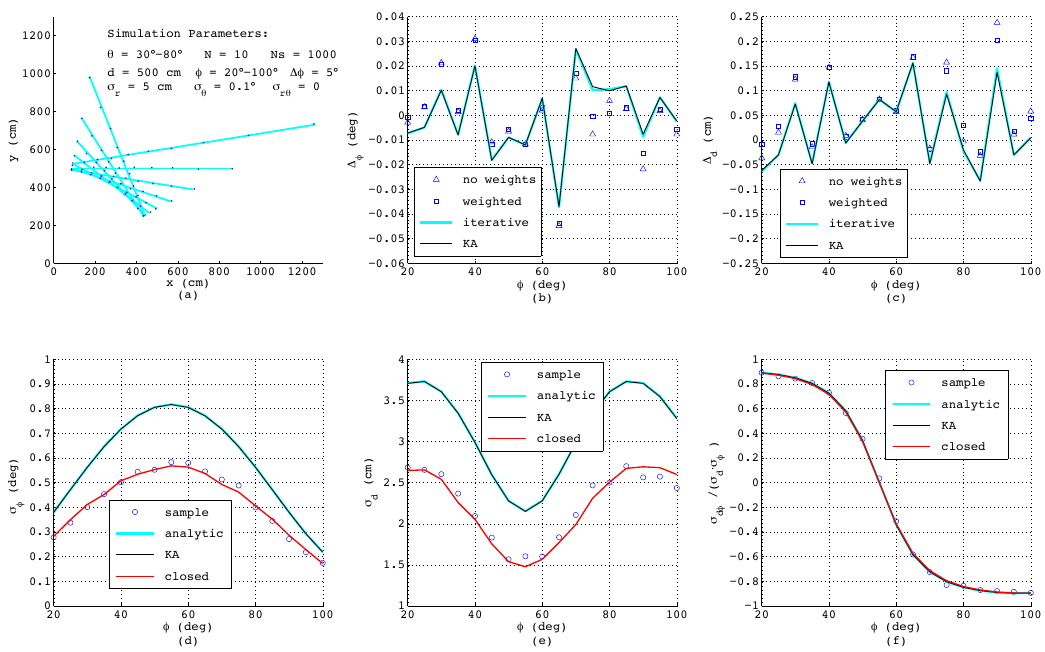
Figure 10. Results from simulated range-bearing scans with a low number of data points and only an approximately known noise level of the